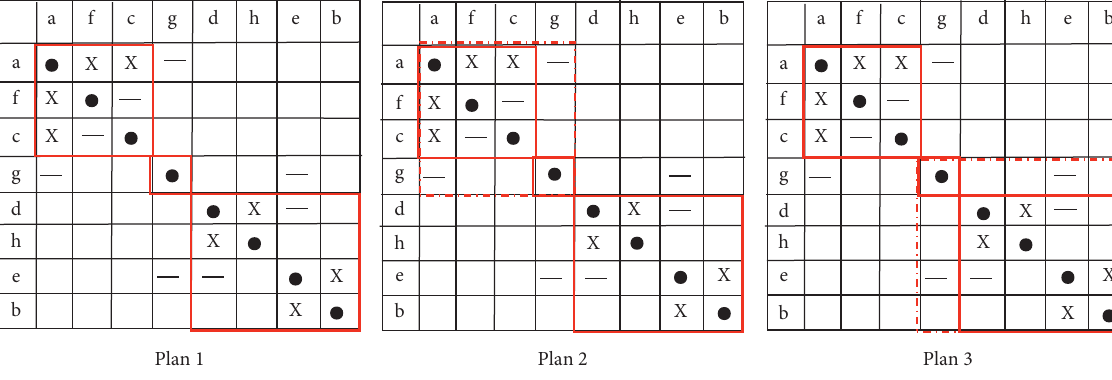
Figure 6: Modularization plans based on DSM